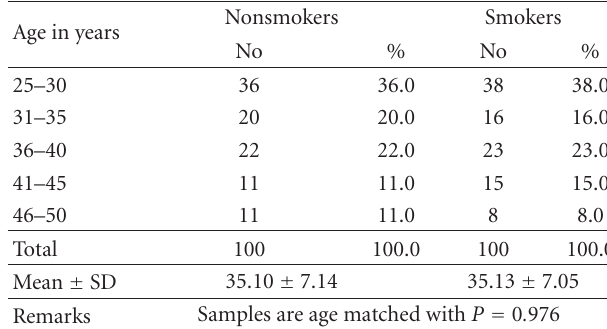
Table 1: Age distribution.